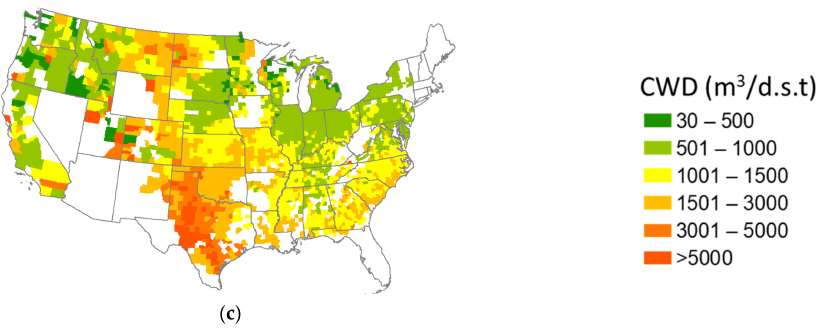
Figure 9. County-level per-unit crop water demand (CWD) (m 3 per dry short ton (d.s.t)) calculated as the volume of water needed per d.s.t (0.907 metric ton of dry biomass) crop produced for ( a ) corn; ( b ) soybeans; and ( c ) wheat.